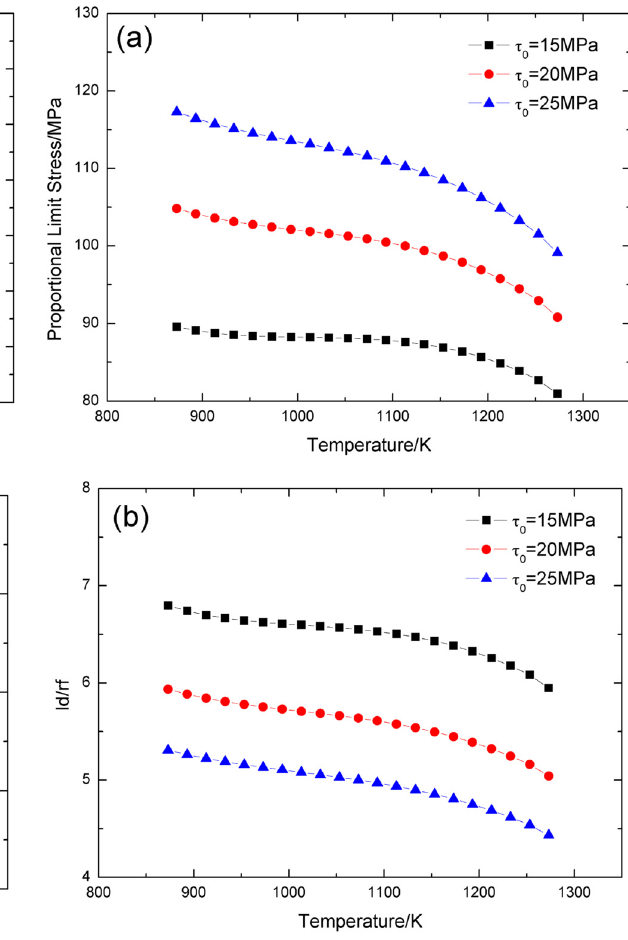
Figure 1: E ff ect of the fi ber volume on ( a ) the PLS versus temperature curves and ( b ) the fi ber/matrix interface debonding length versus temperature curves of SiC/SiC composite.